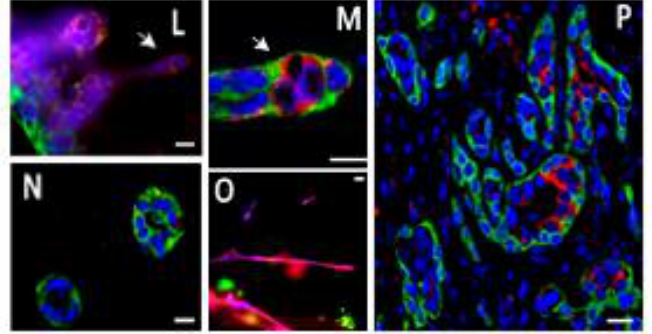
Figure 2. Mouse mammary epithelial cells (Comma D β ) express tubule-like processes in our organoid model. ( A )—Cells were grown in suspension on Cytodex beads. ( B )—In a collagen I gel, cells left the beads and scattered individually. ( C )—In a collagen I/BME gel, they initiated tubule-like processes after 48 h, migrating upright from the bead surface. ( D )—This organization was stable for at least 2 weeks, involving the thickening and branching of these processes. ( E – H )—The tubule-like processes (white arrows) were very cohesive and organized. ( I )—Epithelial cells expressed CK5 (green) and PCNA1 (red), demonstrating a basal phenotype and an active proliferation (PCNA1+) more intense in invading processes (white arrow). ( J )—Apoptosis, as estimated by caspase 3 expression (green), was only found in a small percentage of cells (about 5%), typically in the center of tubule-like processes. ( K )—Epithelial cells covering the microsupports or budding expressed basement membrane receptor integrin α 6 (green) at the outer edge, indicating a polarized organization. ( L – O )—Invading processes were composed of basal (CK5, green) and luminal (CK8, red) cells. Basal cells (red) were cohesive and facing gel ( M , N ). Luminal cells (CK8, red) migrated in looser, thinner structures or as individual cells ( L , O ). They were also found inside the thicker tubule-like processes, facing an emerging lumen, reconstituting their physiological organization in mammary tubules ( M ). ( P )—This cell organization was very similar to the configuration observed in vivo upon the subcutaneous injection of Comma D β cells (CK5 green, CK8 red). Scale bar: 10 µ